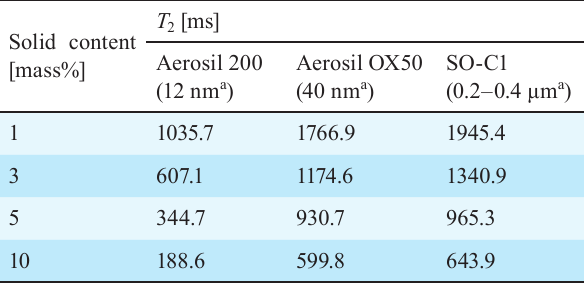
Fig. 2 Effects of primary particle sizes and particle concentrations on the relaxation time; (a) Aerosil 200, (b) Aerosil OX50, and (c) SO-C1. Table 1 The T 2 values of silica particle dispersions with differ - ent solid contents.